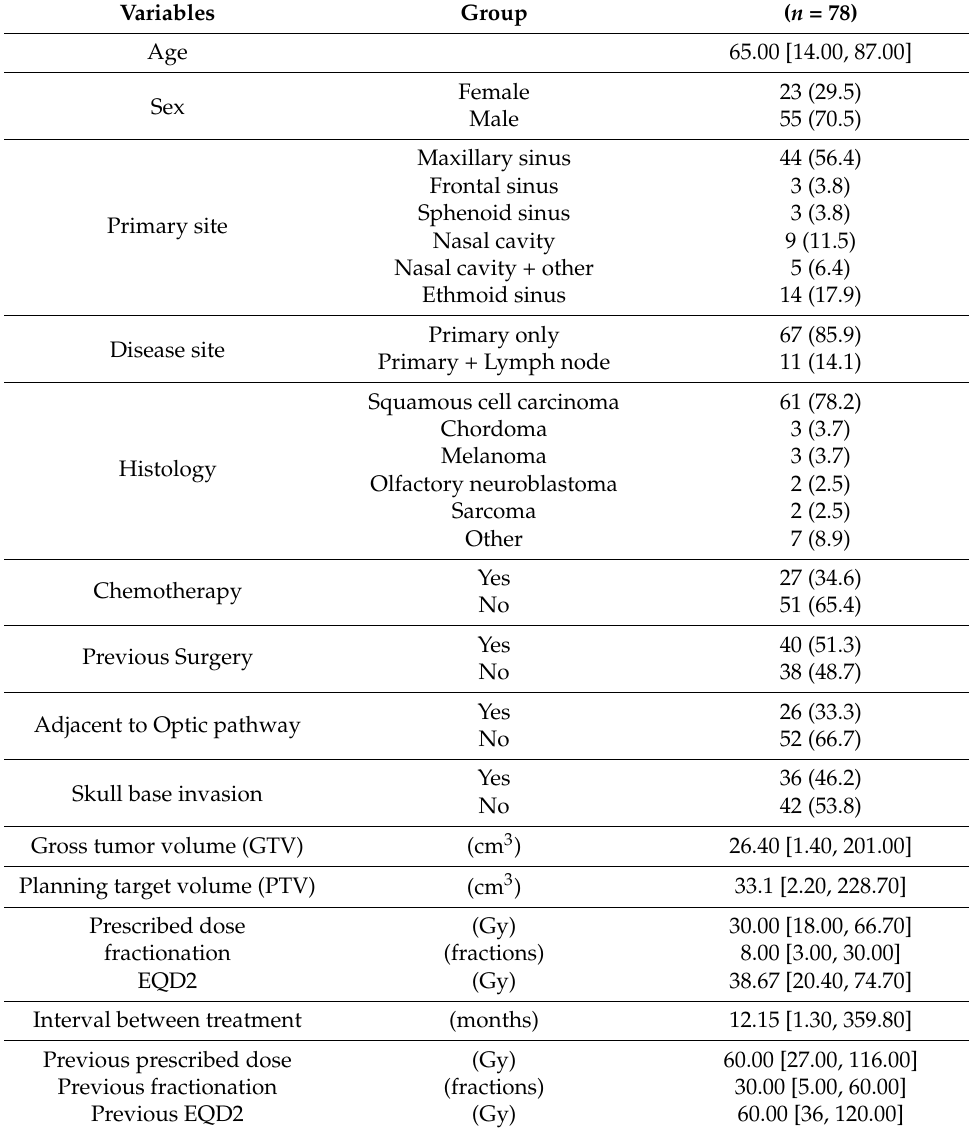
Table 1. Patient